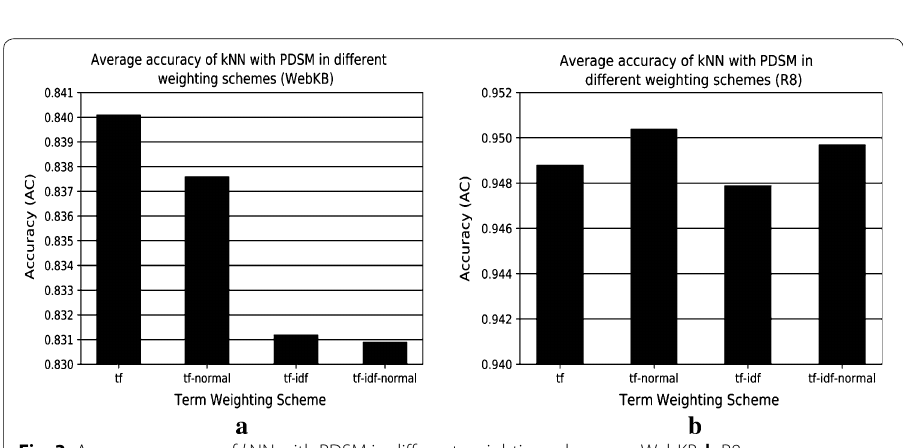
Fig. 3 Average accuracy of k NN with PDSM in different weighting schemes: a WebKB. b